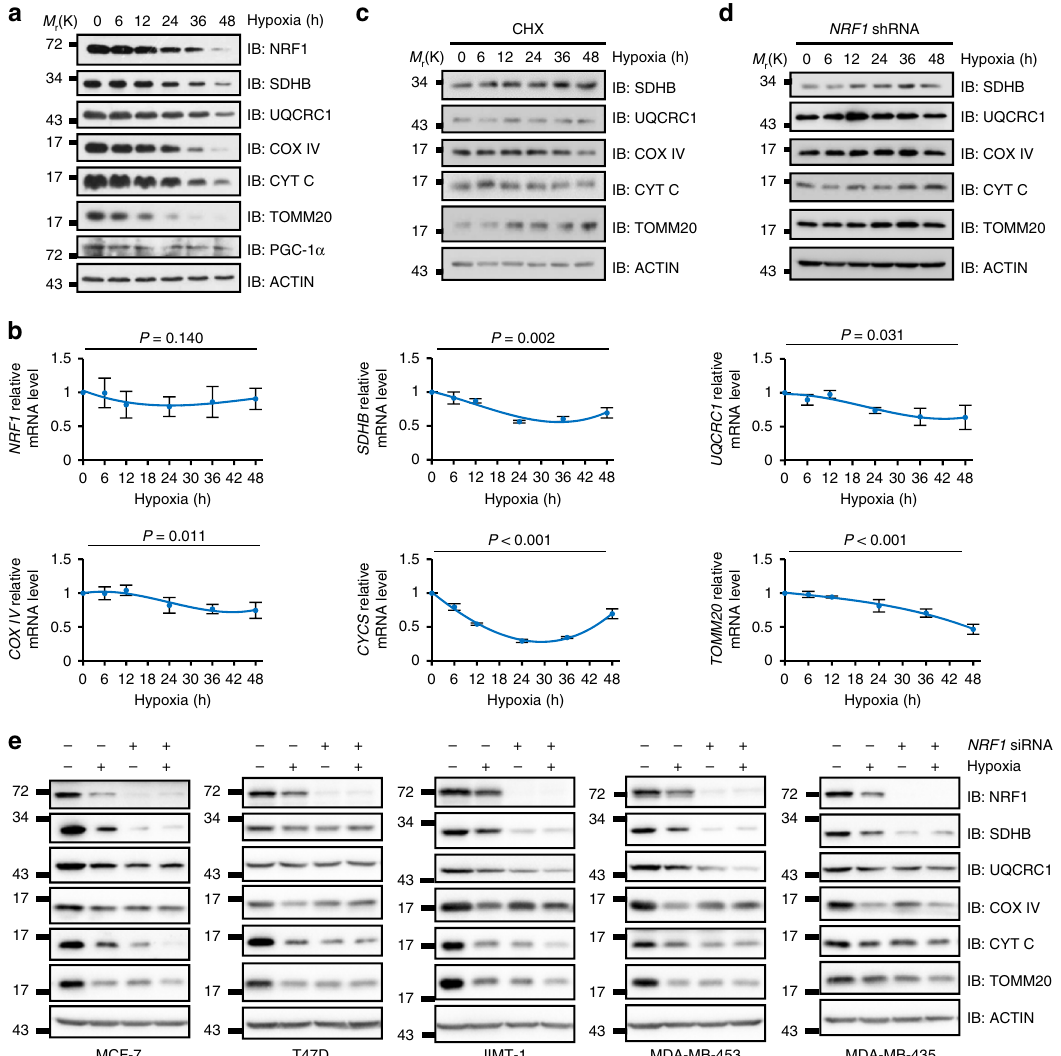
Fig. 2 Hypoxia transcriptionally regulates nuclear-encoded mitochondrial gene expression through NRF1. a , b Analysis of protein levels determined by immunoblotting using the indicated antibodies ( a ), and of mRNA levels, determined by real-time PCR (qRT-PCR) for the indicated genes ( b ), at the indicated time points in MDA-MB-231 cells cultured under hypoxia. qRT-PCR results were normalized to the housekeeping gene B2M . Detailed statistical data of ( a ) are shown in Supplementary Fig. 1a. c MDA-MB-231 cells were pretreated with 25 µ g ml − 1 cycloheximide (CHX) for 2 h under normoxia, then cultured under hypoxic conditions for the indicated time points. Cells were harvested and analyzed by immunoblotting using the indicated antibodies. Detailed statistical data are shown in Supplementary Fig. 2b. d Stable NRF1 -knockdown MDA-MB-231 cells cultured under hypoxia were analyzed by immunoblotting using the indicated antibodies at the indicated time points. Detailed statistical data are shown in Supplementary Fig. 2c. e NRF1 siRNA was transfected into indicated cell lines and cultured under hypoxia for 36 h and then cell lysates were analyzed by immunoblotting using the indicated antibodies. For all panels, error bars indicate s.d., n = 3 biological replicates, average of n = 3 technical replicates for each biological replicate was used in ( b ). One-way ANOVA was used to compare